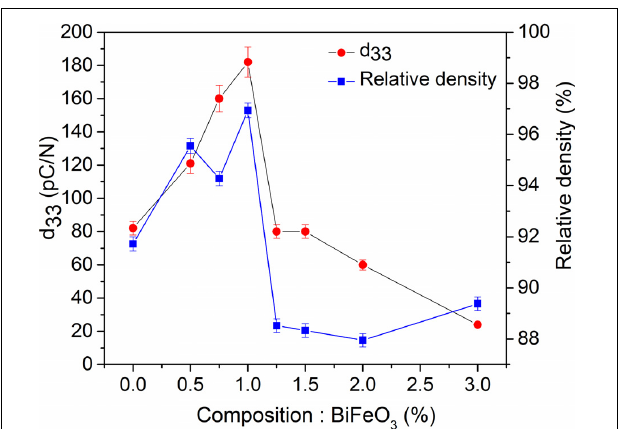
FIGURE 5 | d 33 and relative density as a function of composition in the system (1– x )K 0 . 4 Na 0 . 6 NbO 3 – x BiFeO 3 ( x = 0–3 mol.%). ε r versus temperature for all (1- x )K 0 . 4 Na 0 . 6 NbO 3 – x BiFeO 3 compositions are shown in Figure 4 . At x = 0, T O-T was observed at ∼ 175 ◦ C, which is lower than that for Na 0 . 5 K 0 . 5 NbO 3 ceramics